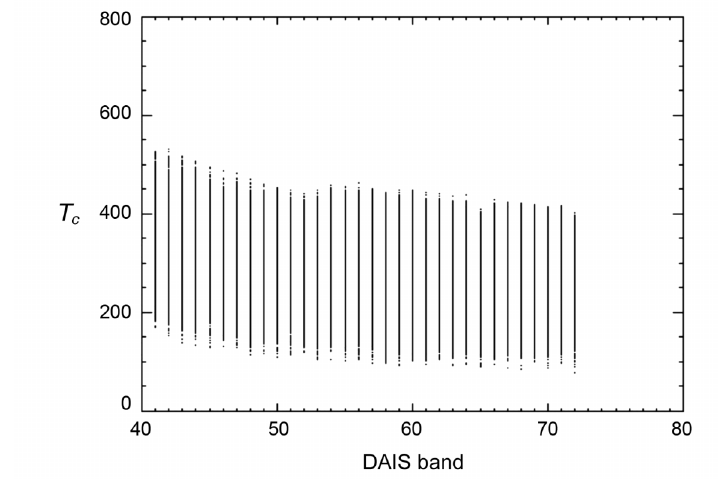
Fig. 3. T c solutions calculated for each pixel as a function of the DAIS band